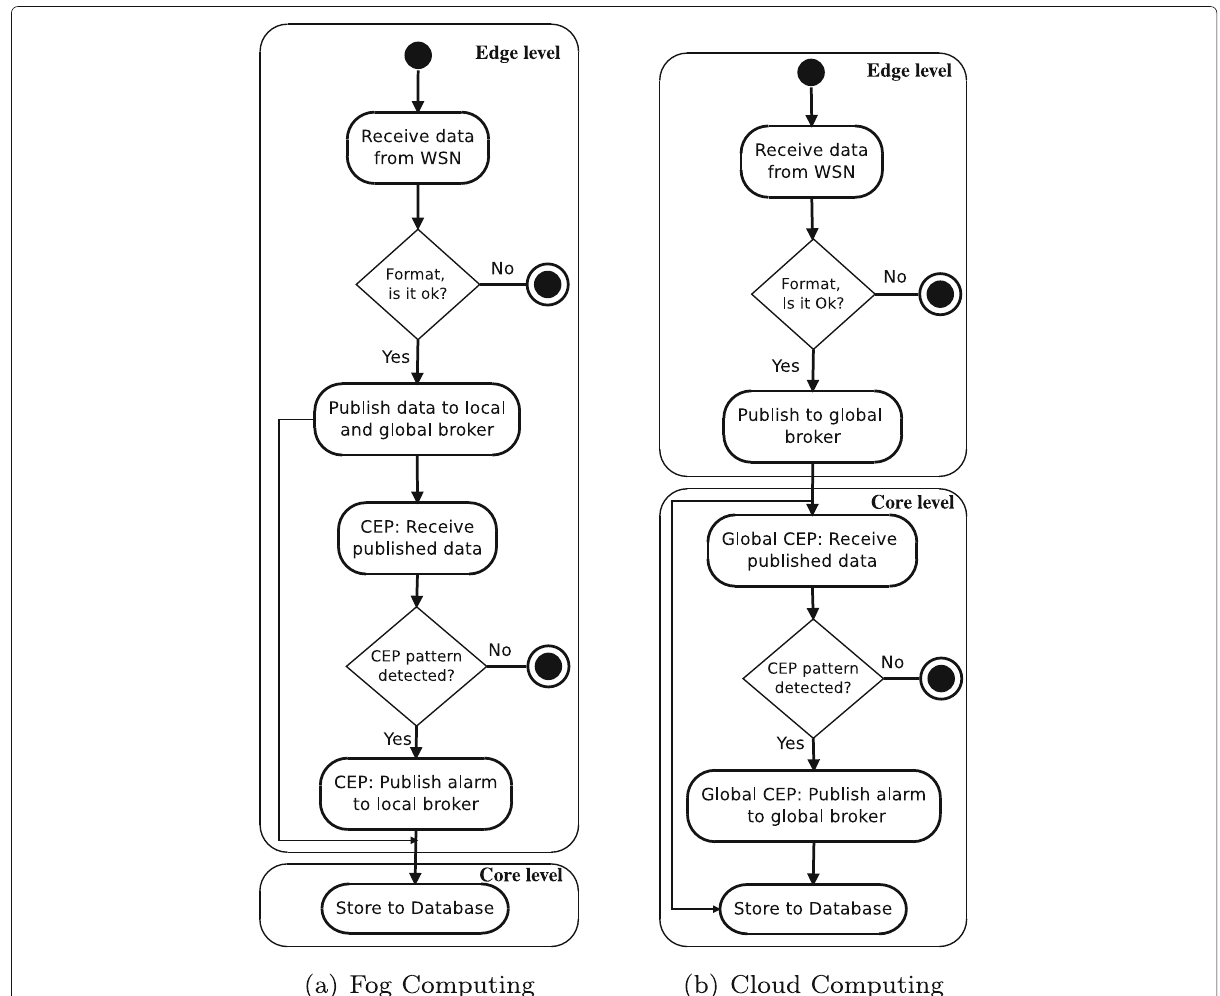
Fig. 5 Data Flow Diagram at the Two Different Levels ( EdgeLevel and CoreLevel ) for the Two Architecture Models: Fog Computing vs. Cloud Computing